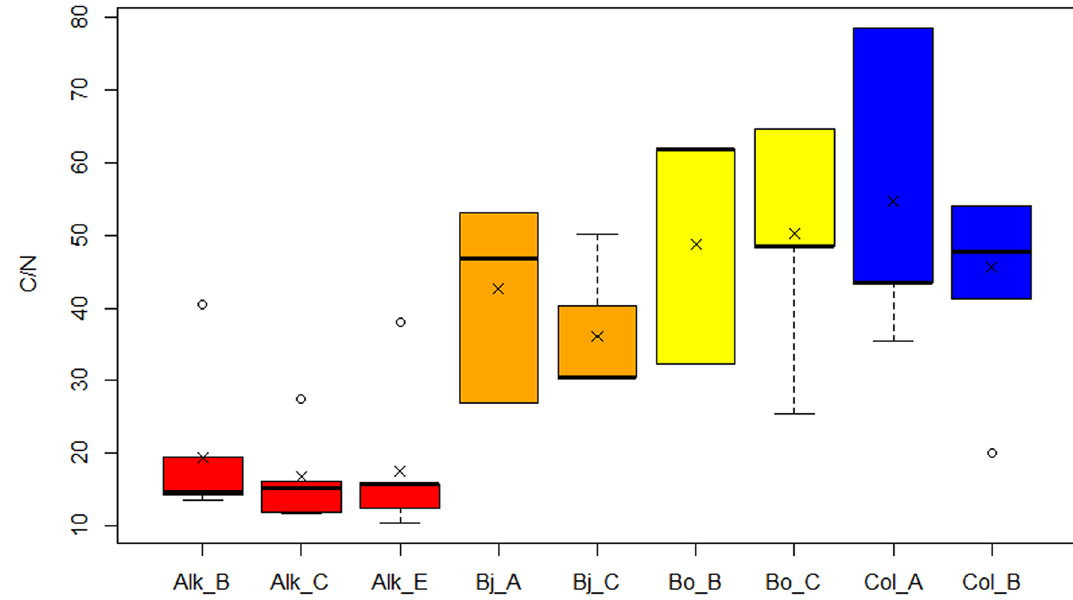
Figure 13. C/N ratio for the focus section study points. The × marks mean value and the vertical line median value. Where applicable, whiskers represent 1st and 3rd quartile. Outliers are shown as dots outside the